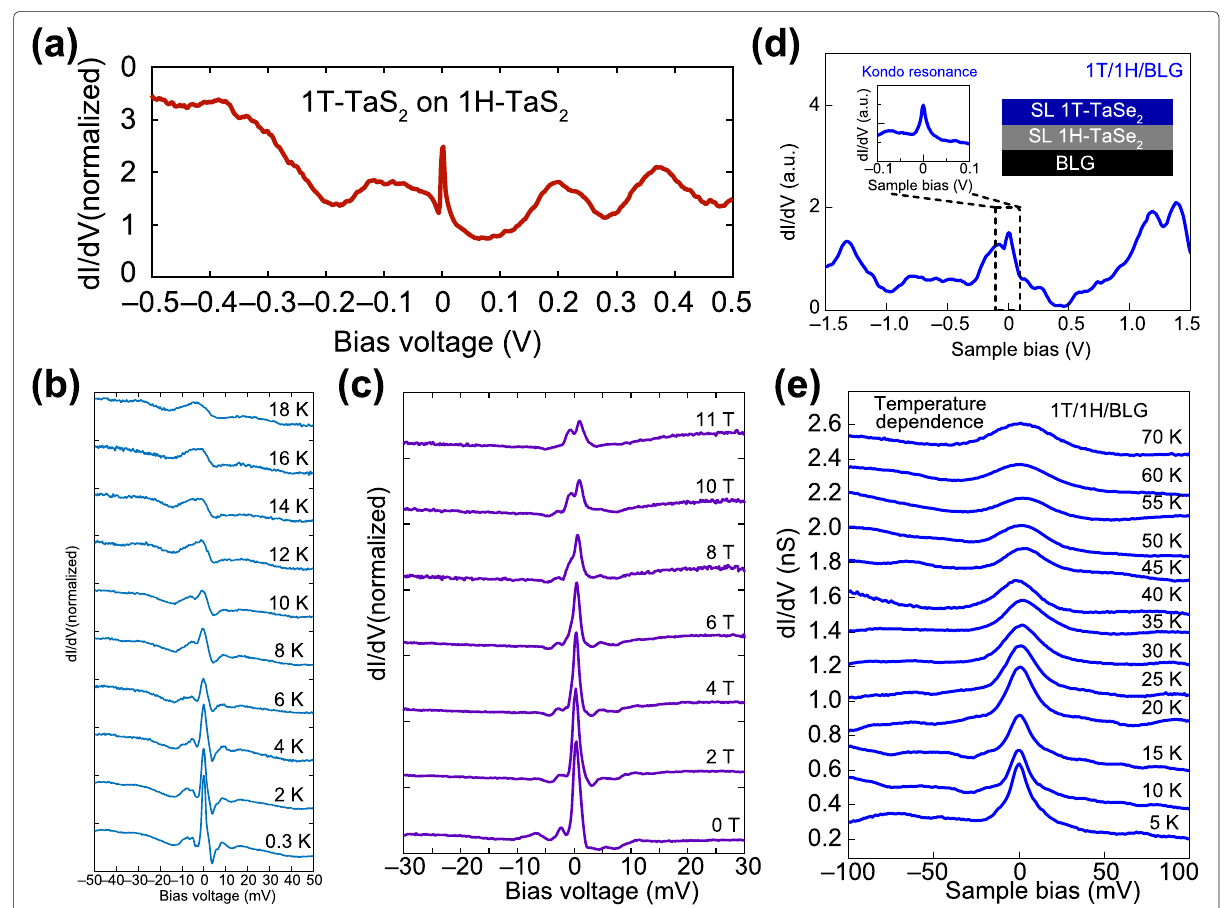
Fig. 12 Kondo resonance of a – c TaS 2 and d – e TaSe 2 heterostructures. a , b Typical dI / dV spectra and the spectra of the Kondo resonance measured at different temperatures on 1 T /1 H -TaS 2 vertical heterostructures. c Magnetic field dependence of the Kondo resonance in tunneling spectra of 1 T /1 H -TaS 2 . d , e Typical dI / dV spectra and the spectra of the Kondo resonance measured at different temperatures on the 1 T /1 H -TaSe 2 vertical heterostructures.Taken from ref. [35,